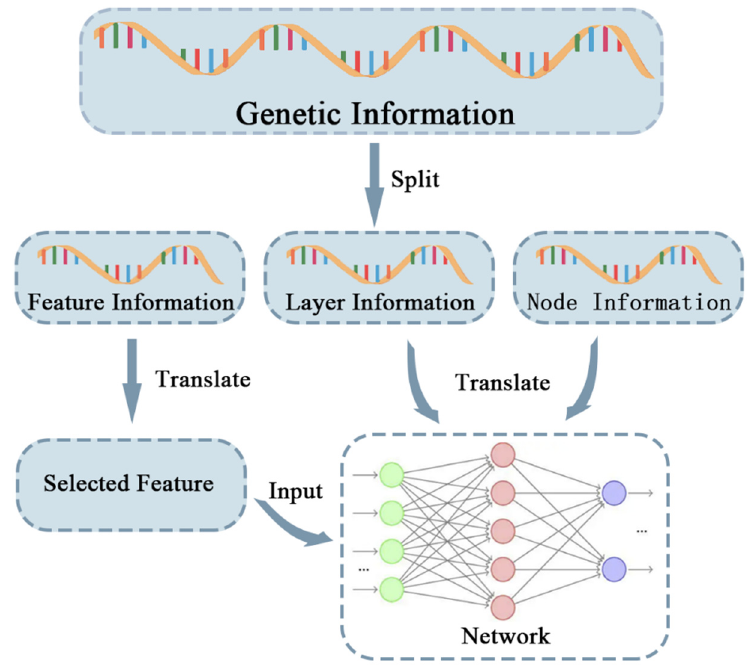
Figure 3. Genetic